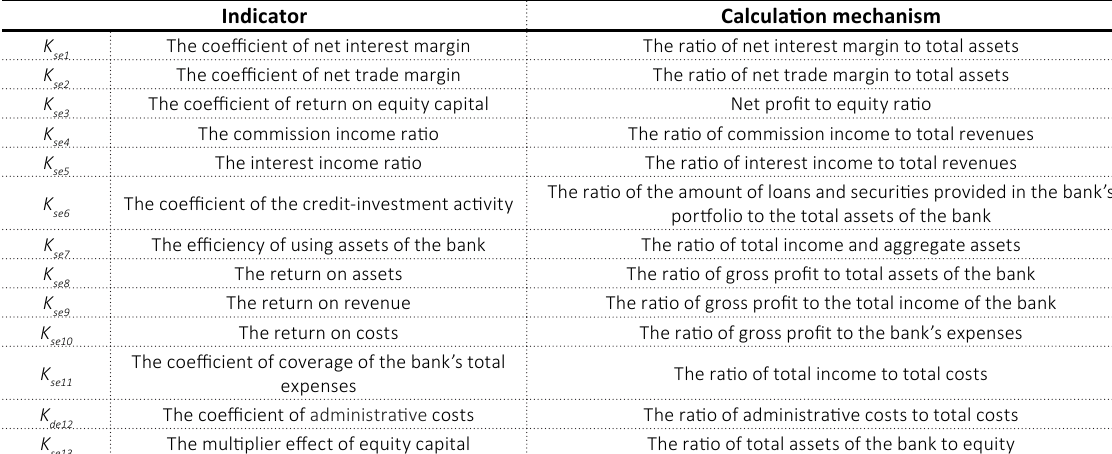
Source: Compiled by the authors.